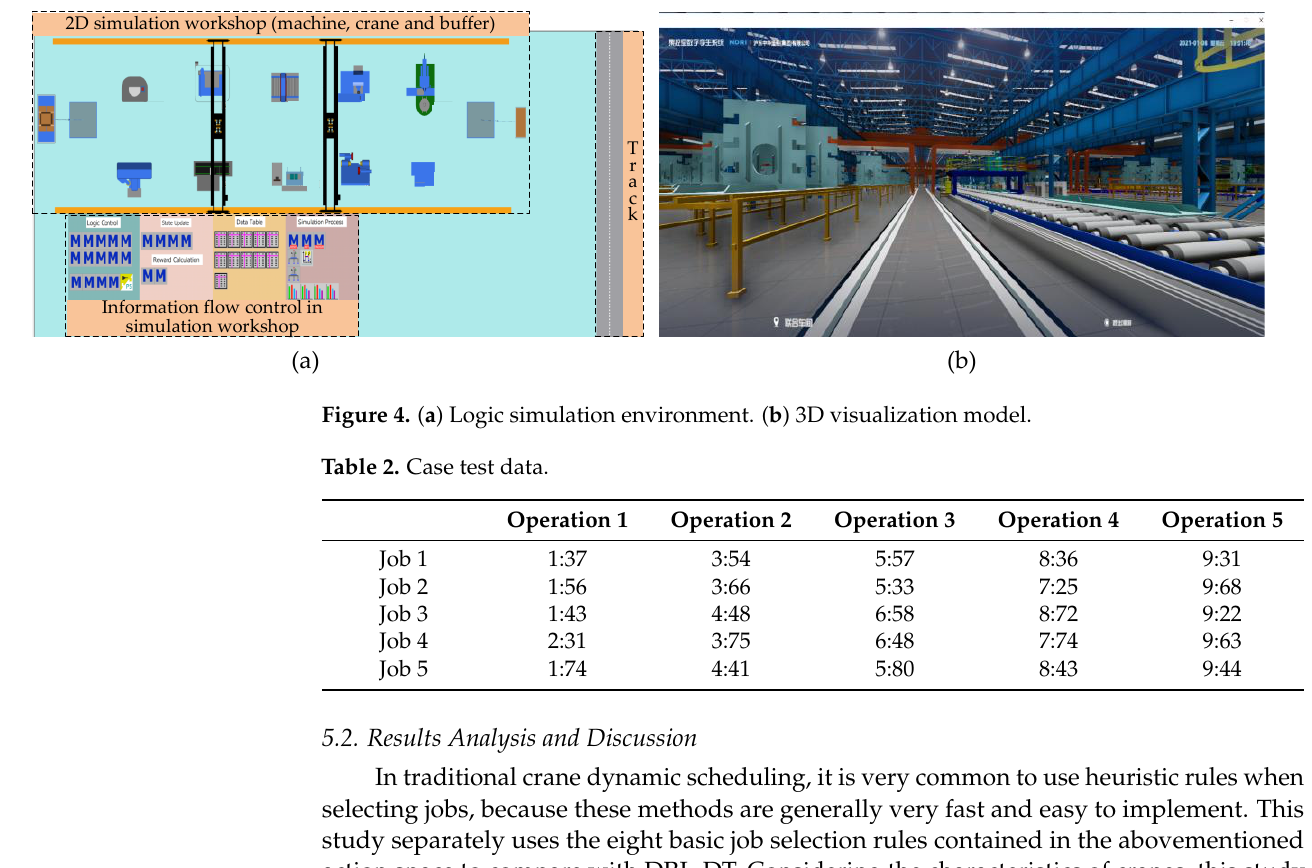
Table 2. Case test data.